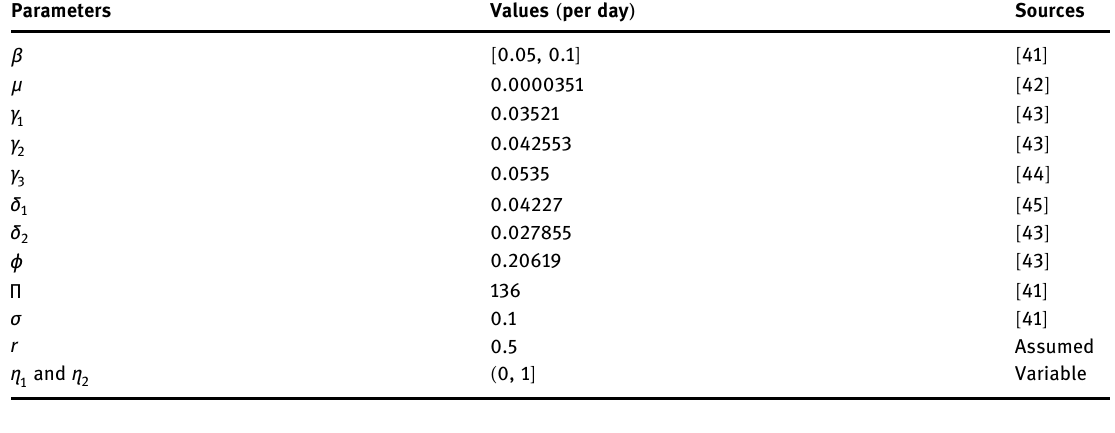
Table 1: Estimated values for the parameters of the model ( 1 )